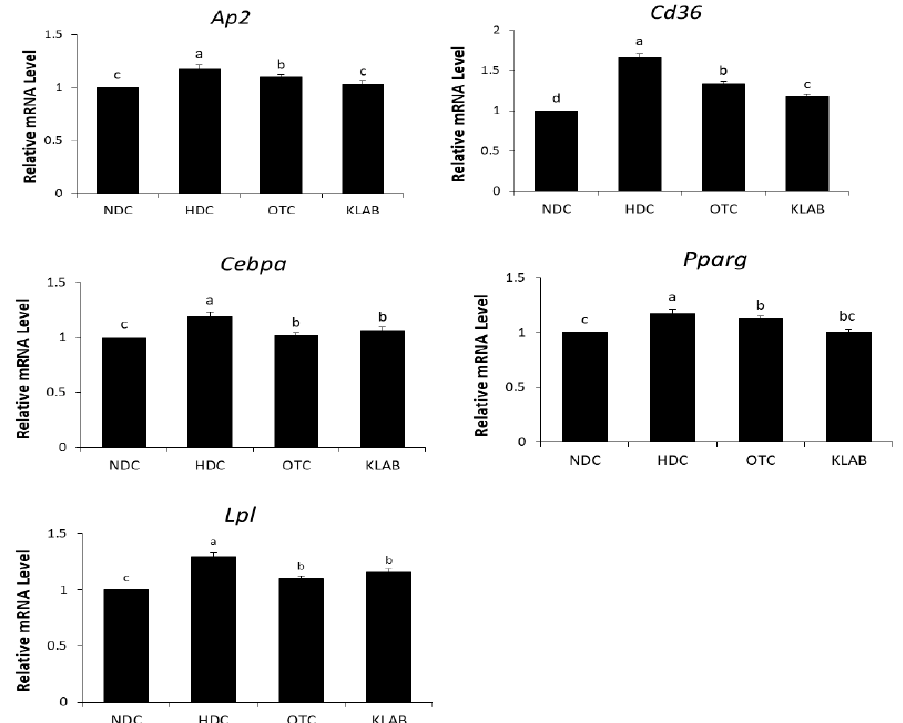
Figure 6. Effect of L. brevis OPK-3 on mRNA levels of adipogenic genes in the white adipose tissue of C57BL/6N mice. Results are Mean ± S.D of 10 mice per group. a-b-c; Values with different superscripts are significantly different by ANOVA with Duncan’s multiple range test at p < 0.05. NDC: Normal diet control, HDC: High fat diet control; OTC: high-fat diet plus L-ornithine 20 mg/kg; KLAB: High fat diet plus 1×10 9 CFU of L. brevis OPK-3 per mouse. Pparg : Peroxisome proliferator-activated receptor gamma; Cebpa : CCAAT/enhancer-binding protein alpha; Ap2 : Fatty acid binding protein; Lpl : Lipoprotein lipase.